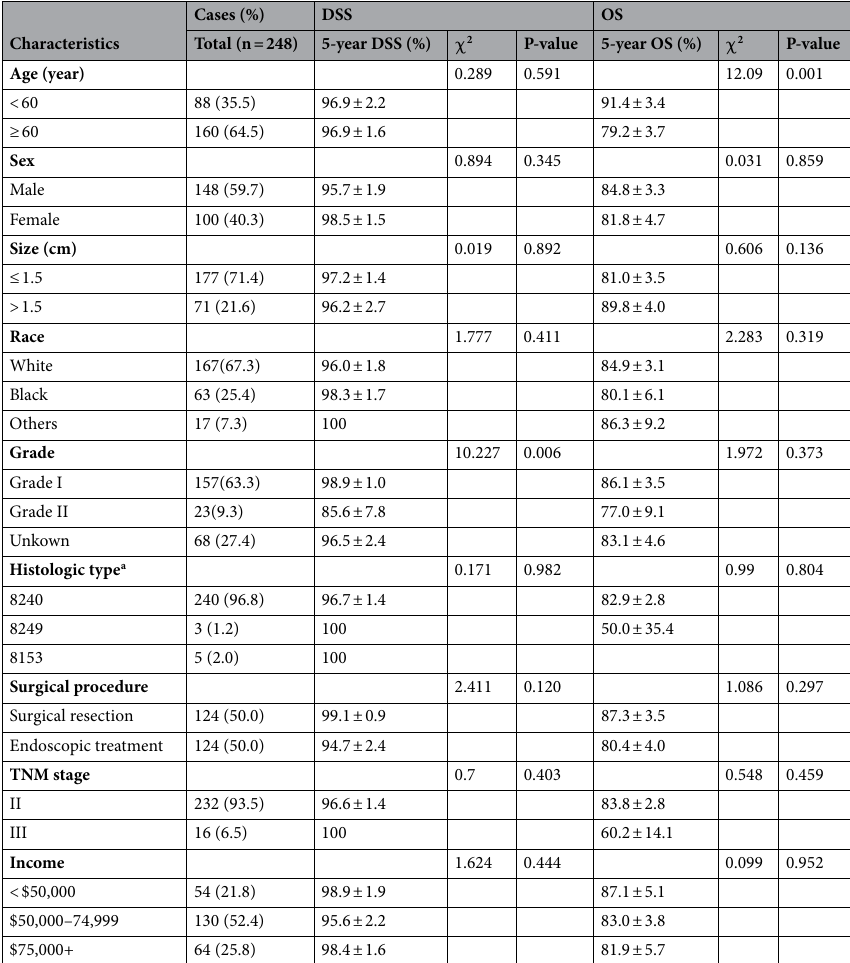
Table 2. Factors associated with disease-specific survival and overall survival after PSM for non-ampullary duodenal neuroendocrine tumors (d-NETs). DSS disease-specific survival, OS overall survival, PSM propensity score matching. a International Classification of Diseases for Oncology, 3rd Edition (ICD-O-3): 8240, Carcinoid tumor; 8153,Gastrinoma, 8249, Atypical Carcinoid tumor. WHO: World Health Organization. Grade I,well differentiated; Grade II, moderately